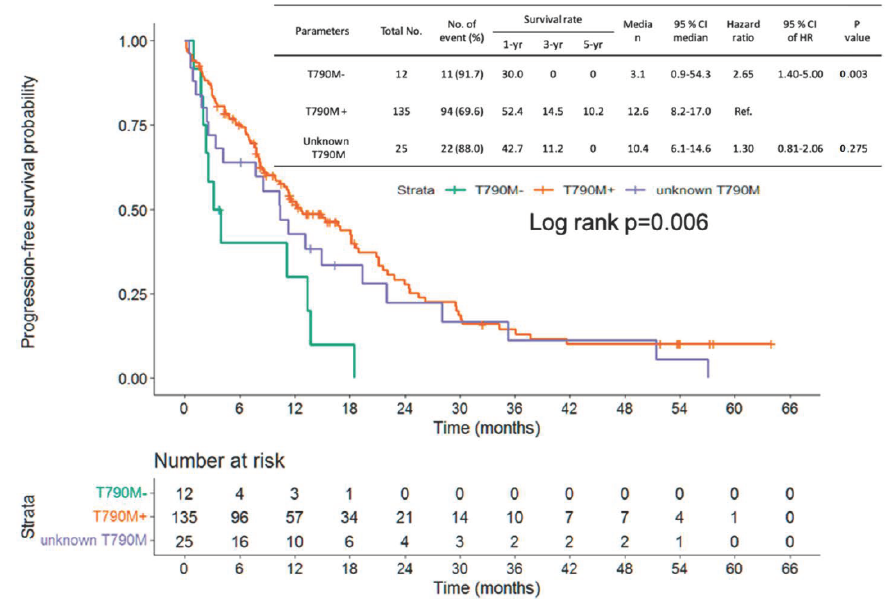
Figure 4. Progression-free survival of osimertinib based on T790M status.